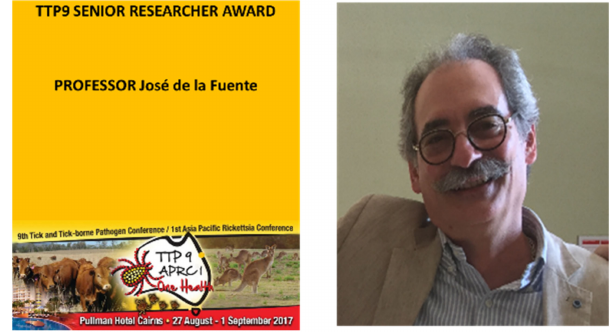
Figure 4. TTP9 Senior Researcher